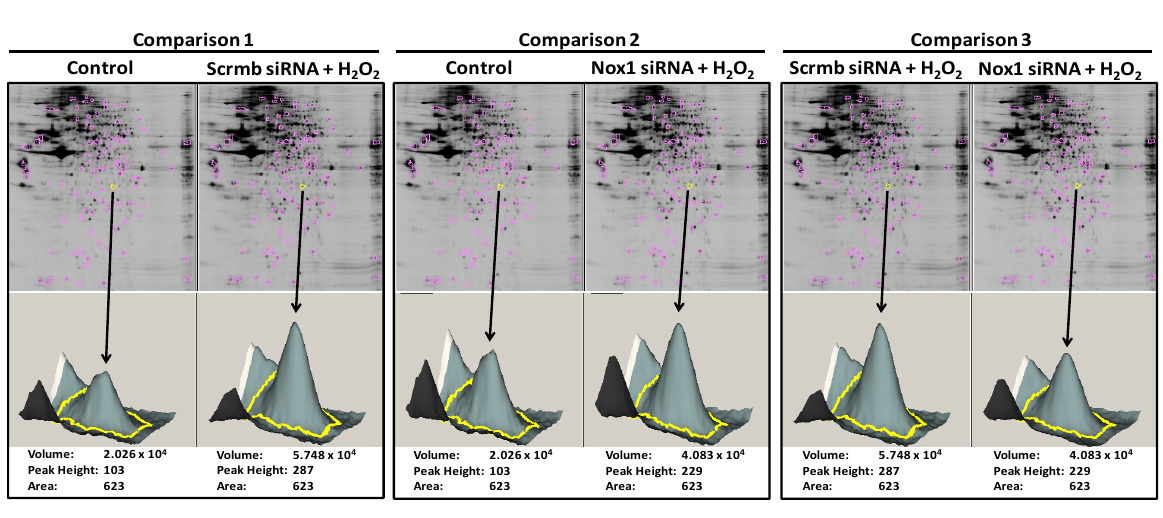
Figure 2. 3D view of representative spot intensity. Spot 63 is shown with the DeCyder calculation of fluorescence intensity for each treatment group per comparison. The selected spot is marked by a yellow circle on the 2D gel ( n = 1).